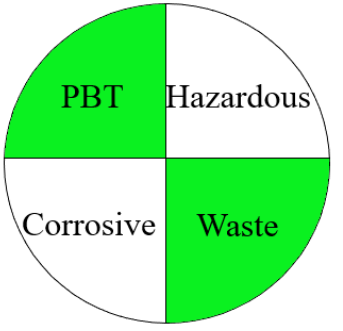
Figure 1. NEMI pictogram example.